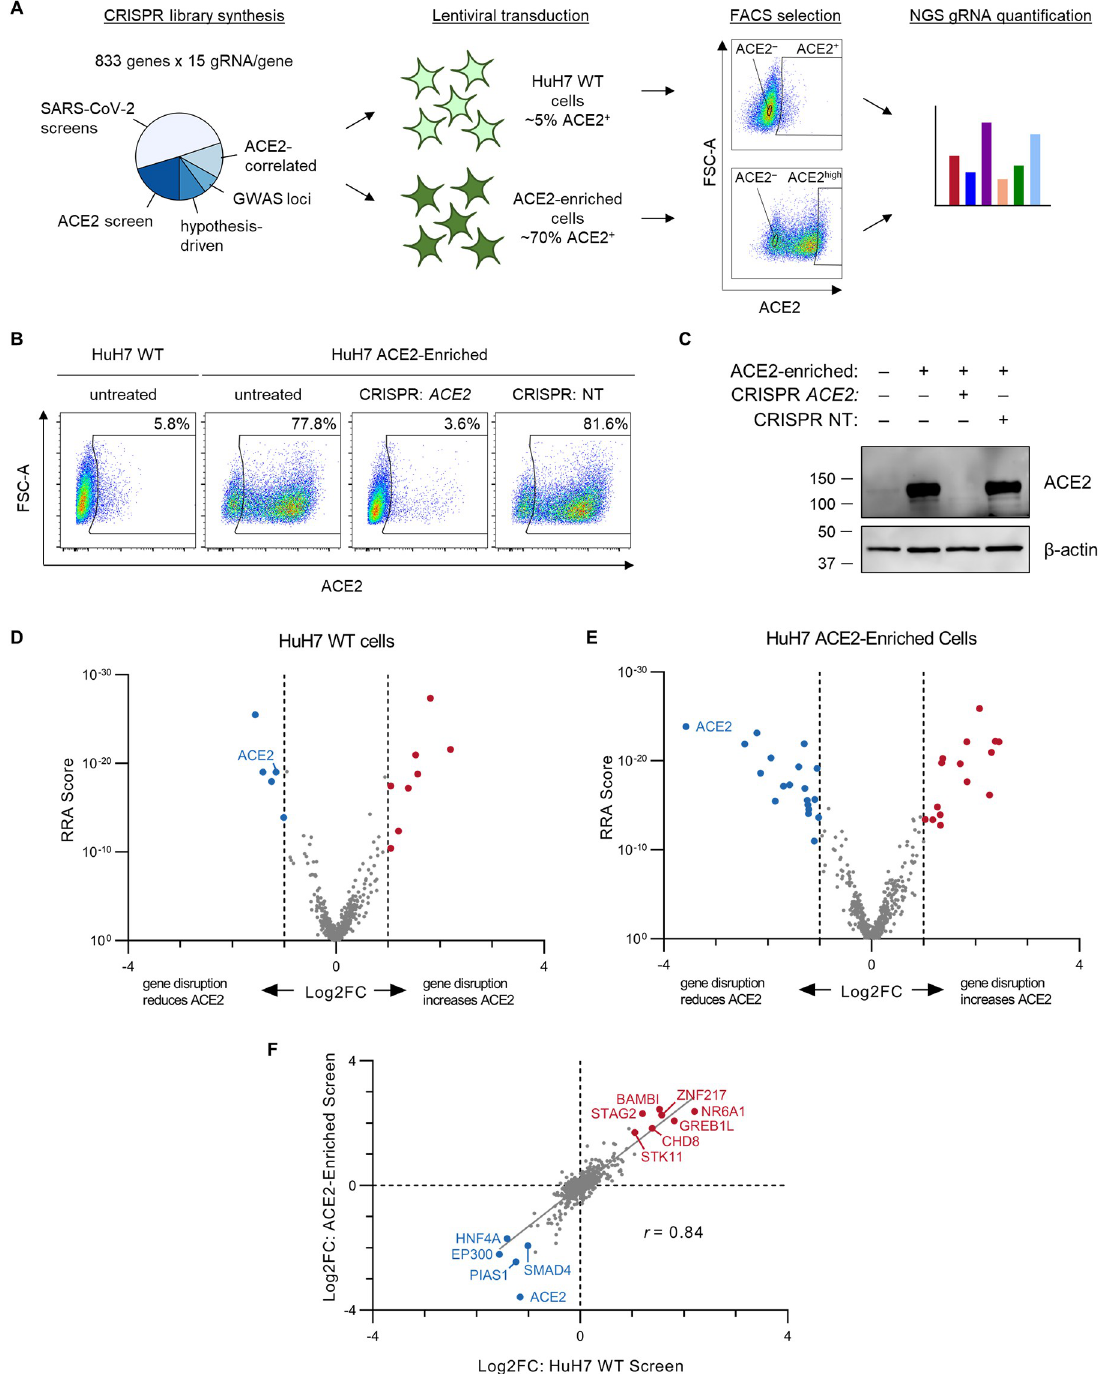
Fig 1. CRISPR screen for ACE2 modifiers. (A) Schematic of ACE2 CRISPR screening strategy. A total of 833 candidate ACE2 modifiers were selected from a variety of sources and targeted with a high-resolution CRISPR library containing 15 gRNAs per gene. This library was then used to screen in parallel both wild-type and ACE2-enriched HuH7 cells. Selection of individual cells was performed based on surface ACE2 abundance by FACS and individual gRNA abundance in each sorted subpopulation was quantified by massively parallel sequencing. (B) Flow cytometry plots of ACE2 surface abundance for wild-type or serially ACE2-enriched HuH7 cells, with or without transduction of a lentiviral CRISPR construct with a ACE2 -targeting or control nontargeting (NT) gRNA. ACE2-positive gates were established on unstained wild-type cells. (C) Immunoblot for ACE2 and β -actin in lysates prepared from the same cell populations as in (B). (D-E) Volcano plots of MAGeCK Robust Rank Aggregation scores relative to gene-level gRNA log 2 fold-change for each gene tested